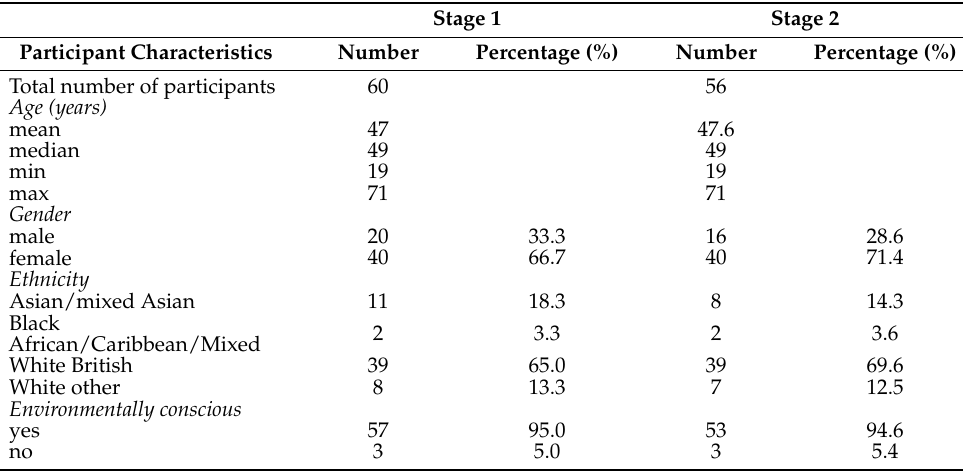
Table 2. Demographic characteristics of focus group